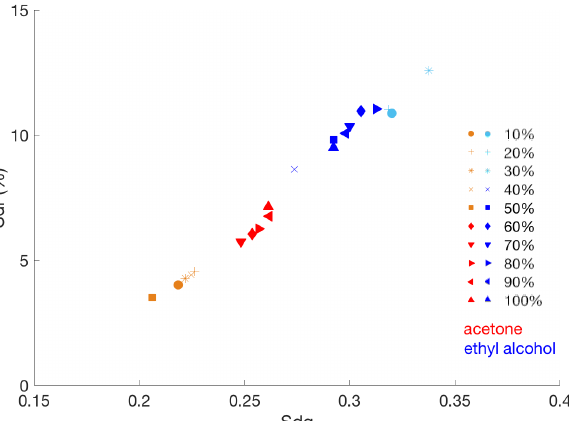
Figure 11. Interrelation between RMS gradient and developed interfacial area ratio for the different chemical cleanings. The different symbols represent the different concentrations of acetone (red- orange) and ethyl alcohol (blue-light